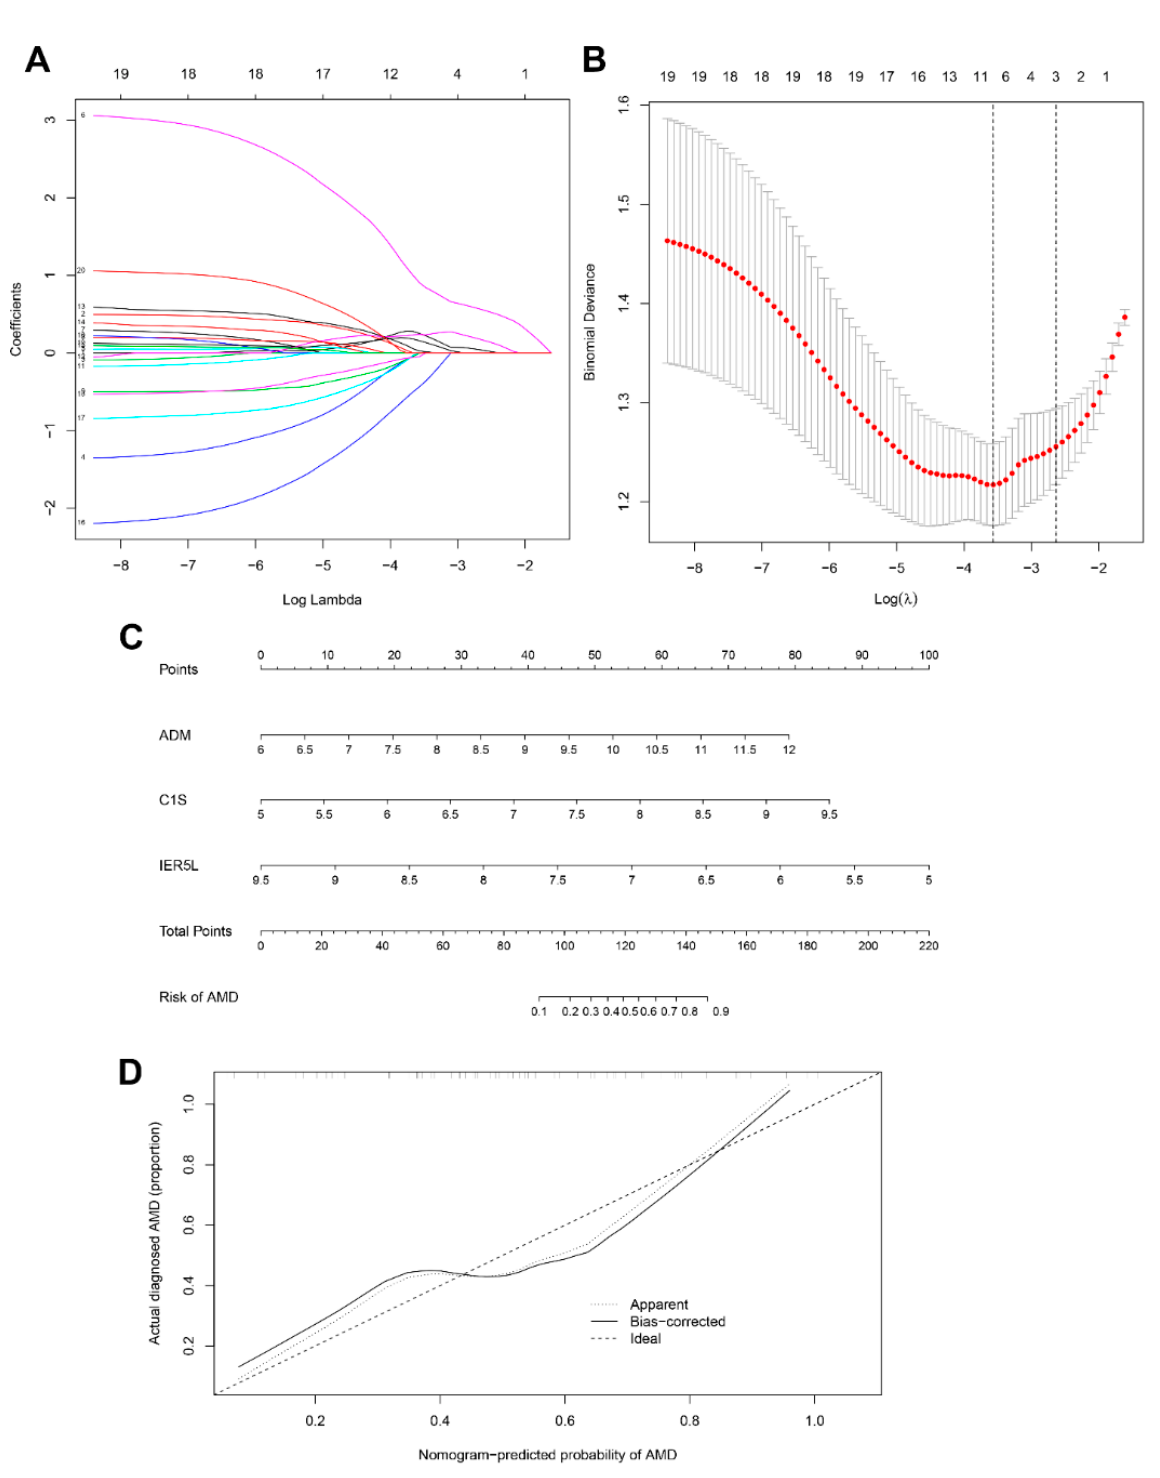
Figure 4. Diagnostic prediction model for AMD. ( A , B ) LASSO model. ( C ) Nomogram model for AMD prediction based on C1S, ADM, and IER5L. ( D ) Calibration curve of the 3-gene model.